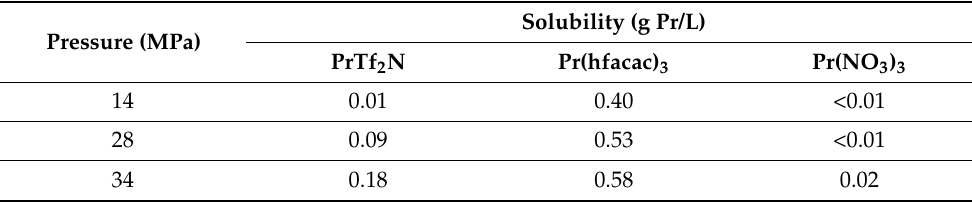
Table 3. Results from the solubility studies of Pr salts in the scCO 2 phase in contact with the IL phase and with ~5 mol% TBP added at 308 K and three